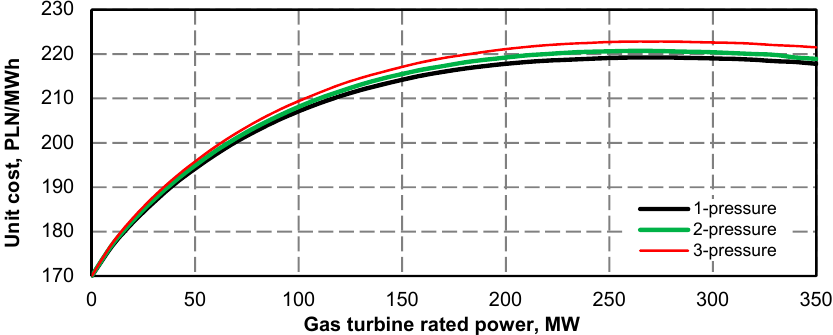
Figure 48. The unit generation cost for electric power as a function of gas turbine rated power for operating the gas turbine shut o ff during the night low power demand (“night valley”) and various structures of recovery boiler ( e c = 9.52 PLN / GJ, e g = 22 PLN / GJ, (k el )ex = 170.0 PLN /